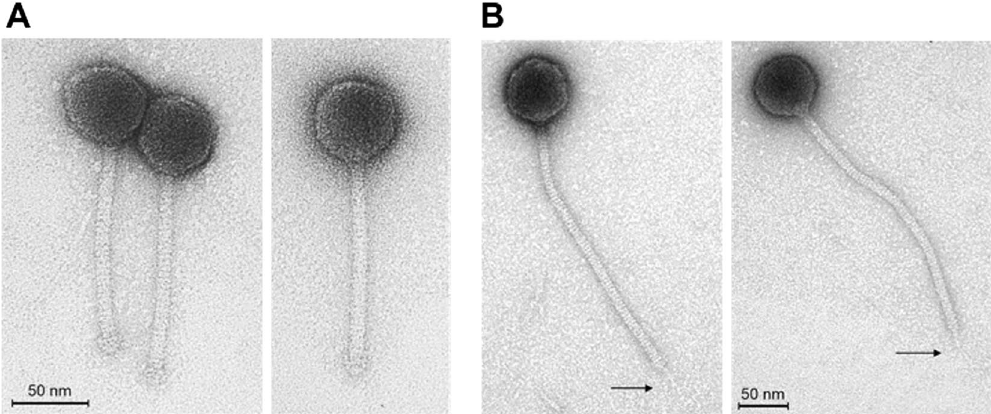
Figure 1. Transmission electron micrograph showing the long-tailed Siphoviridae morphotype of phage Anath ( A ) and phage Lana ( B ). The arrows indicate faint central tail-fibre